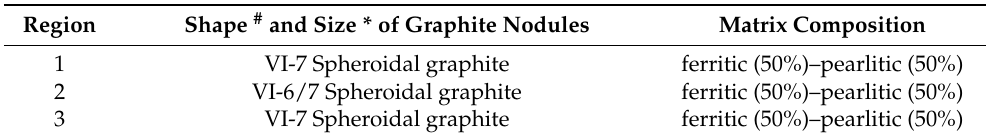
# shape of graphite nodules: VI corresponds to regular spheroidal graphite. * size of graphite nodules: 6 corre- sponds to a diameter in the range between 30 µ m and 60 µ m, and 7 to a diameter in the range between 15 µ m and 30 µ